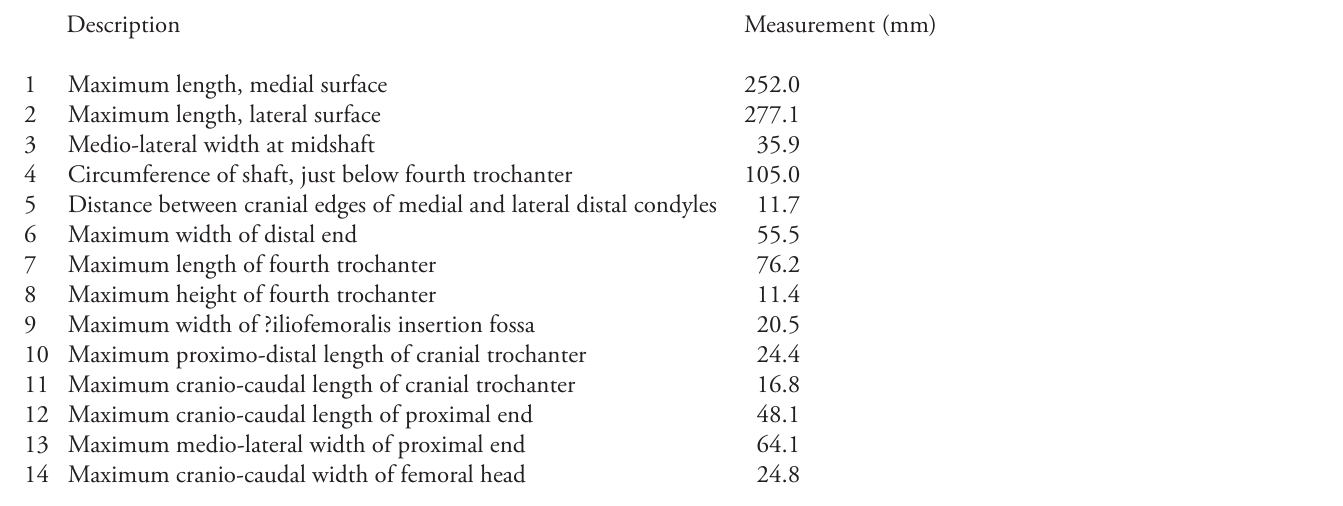
Table 1. Measurements of RAM 9396, left femur of cf. Edmontosaurus annectens . Measurement